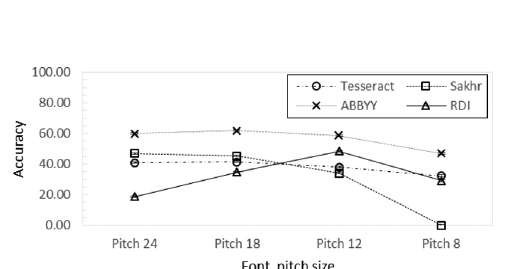
Figure 8. Digit, punctuation and diacritics accuracy results from the OCR system evaluation